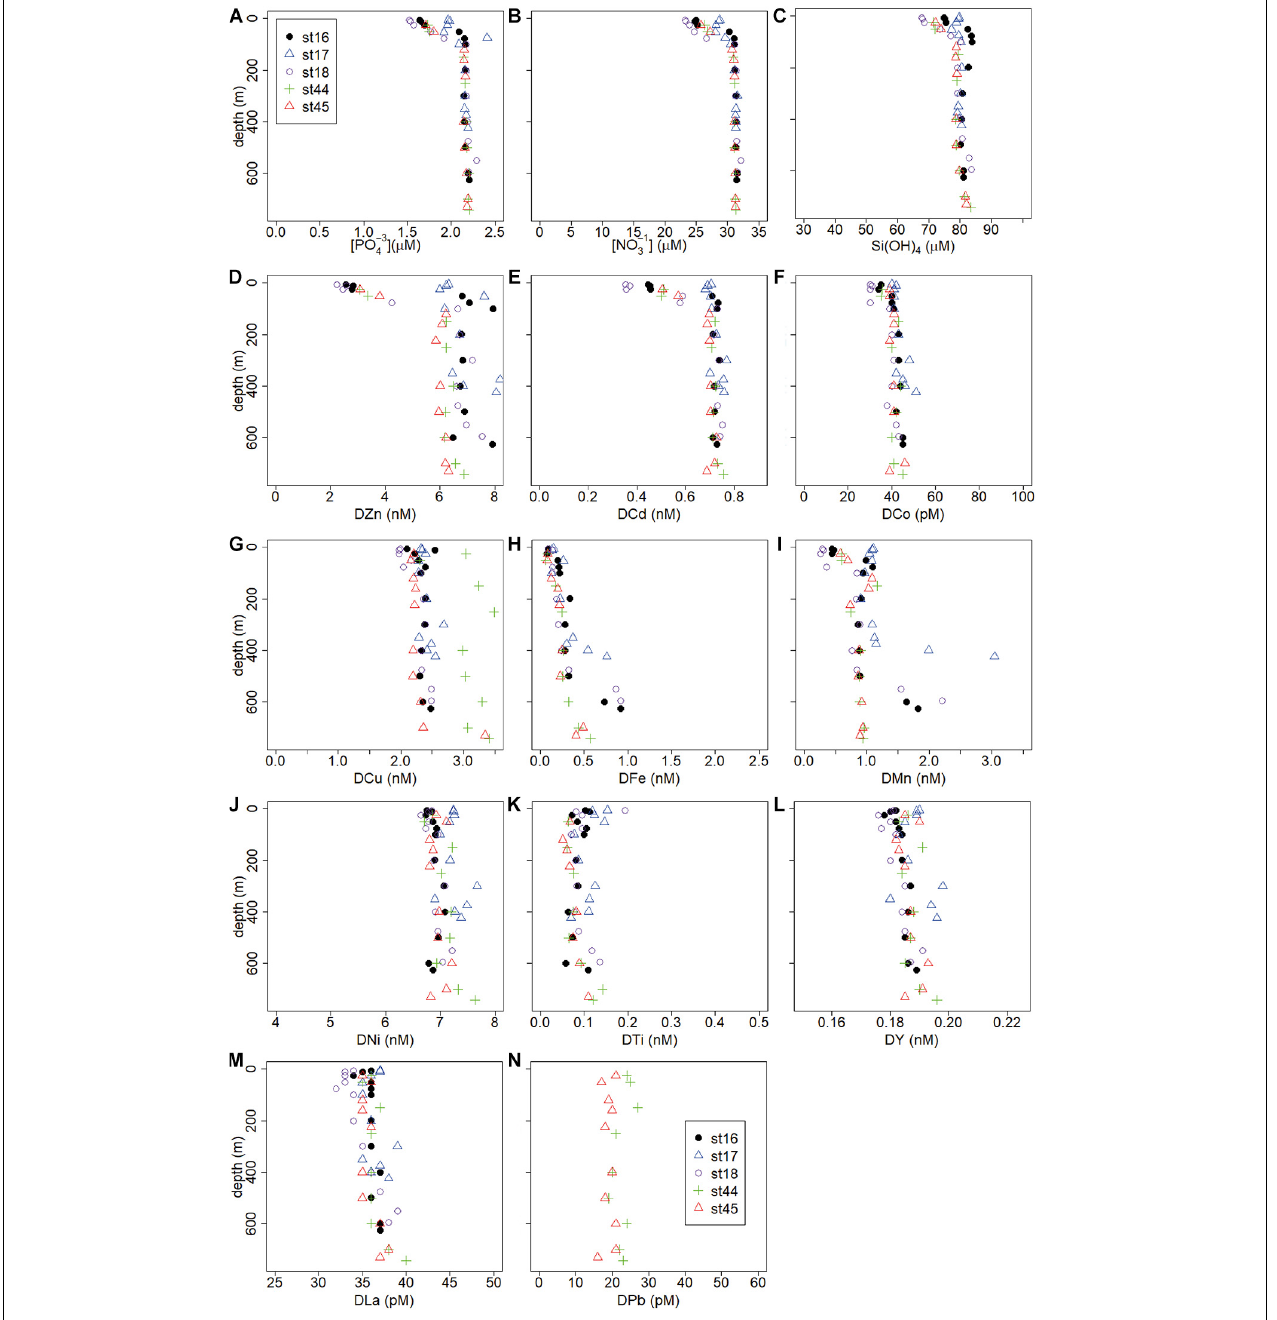
FIGURE 5 | Depth profiles of macro-nutrients ( µ M) and trace metals (nM or pM) of the eastern Ross Sea transect, stations 16–18 and those close to the Ross Ice Sheet stations 44 and 45. (A) PO 43 − , (B) NO 3 − , (C) Si(OH) 4 , (D) DZn, (E) DCd, (F) DCo, (G) DCu, (H) DFe, (I) DMn, (J) DNi, (K) DTi, (L) DY, (M) DLa, (N) DPb.